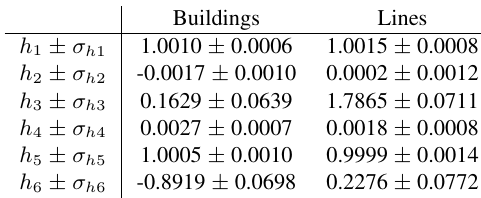
Table 3: Estimated affine parameters for 3K DSM and HSI using extracted building outlines and